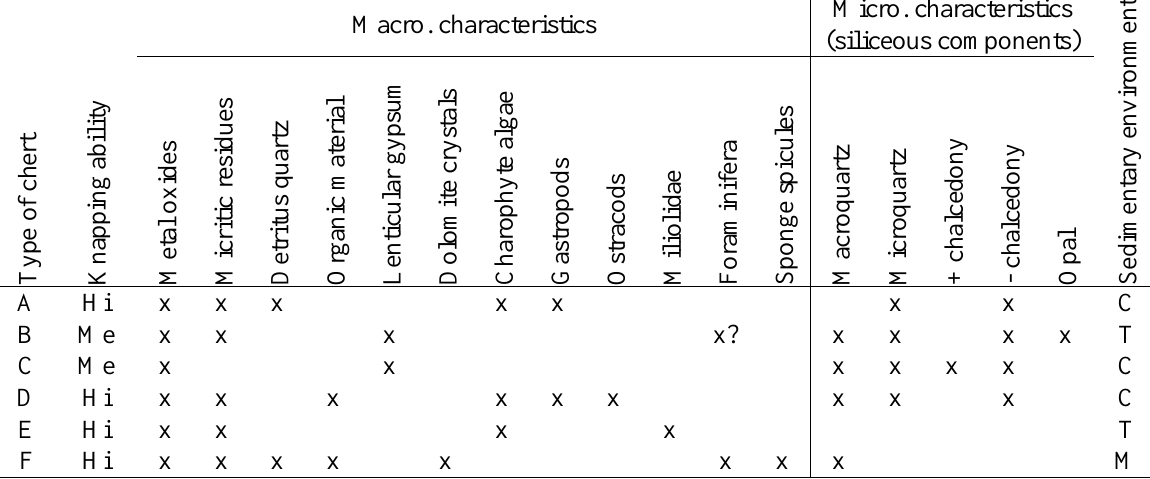
Table 1 – Main characteristics of cherts identified during fieldwork. Abbreviations: Hi - high; Me - medium; C - continental; T - transitional; M -